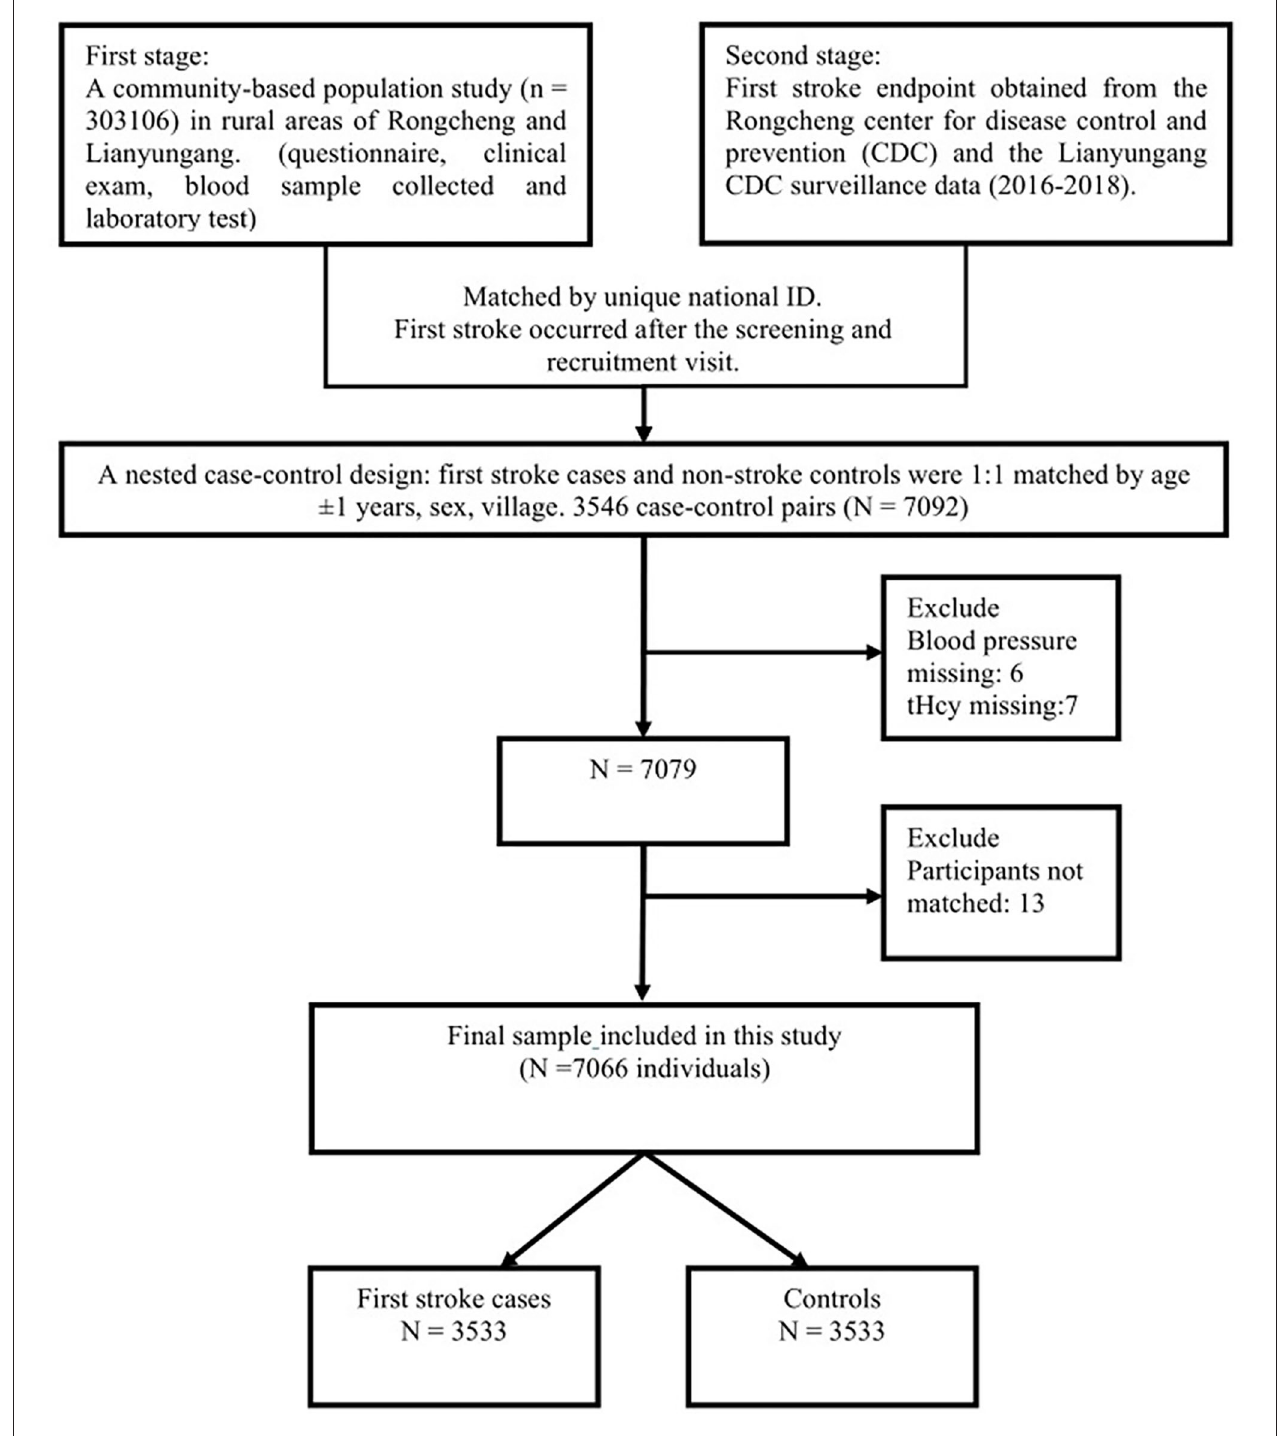
FIGURE 1 | Flow chart of the study design and participants. A total of 3,533 cases were individually matched to 3,533 controls by age ± 1 years, sex, and village.